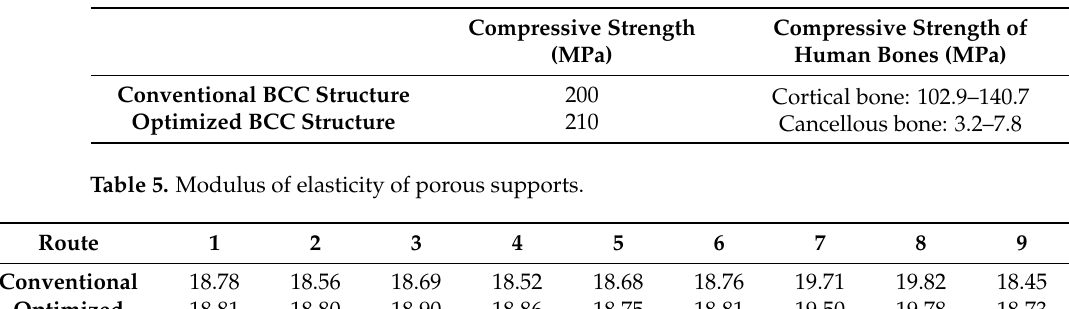
Figure 6. Stress–strain curve.